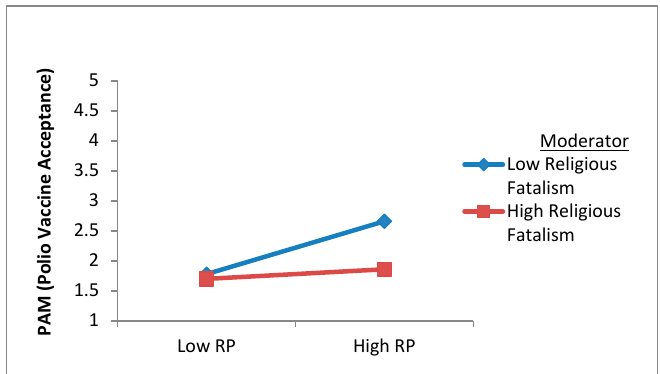
Figure 5. Moderation of religious fatalism.